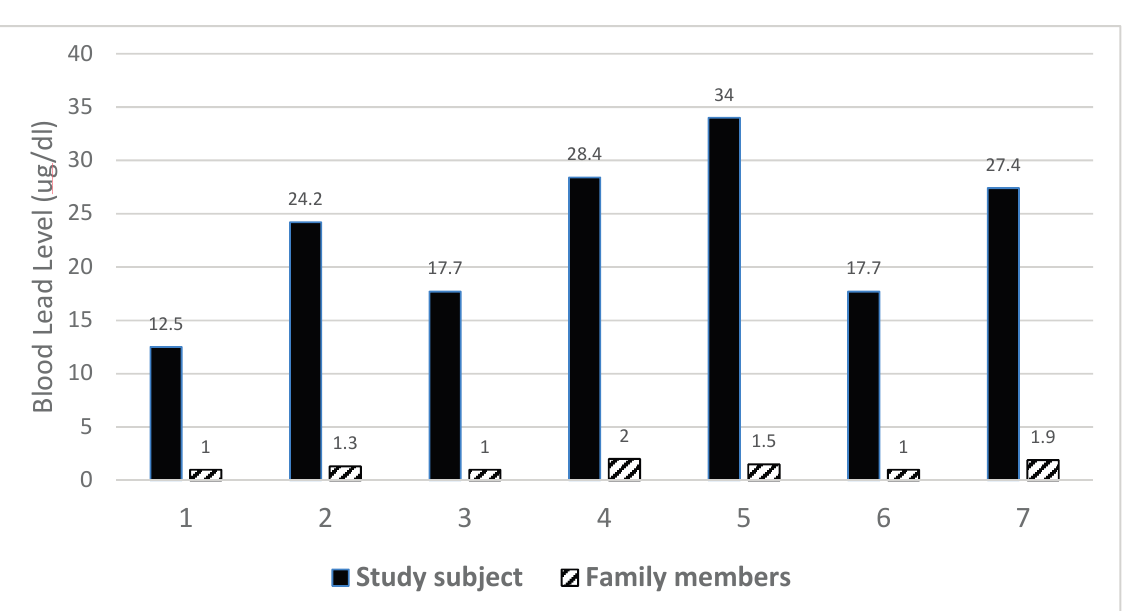
Figure 1. Blood lead trend by subject: 2012 to 2014.